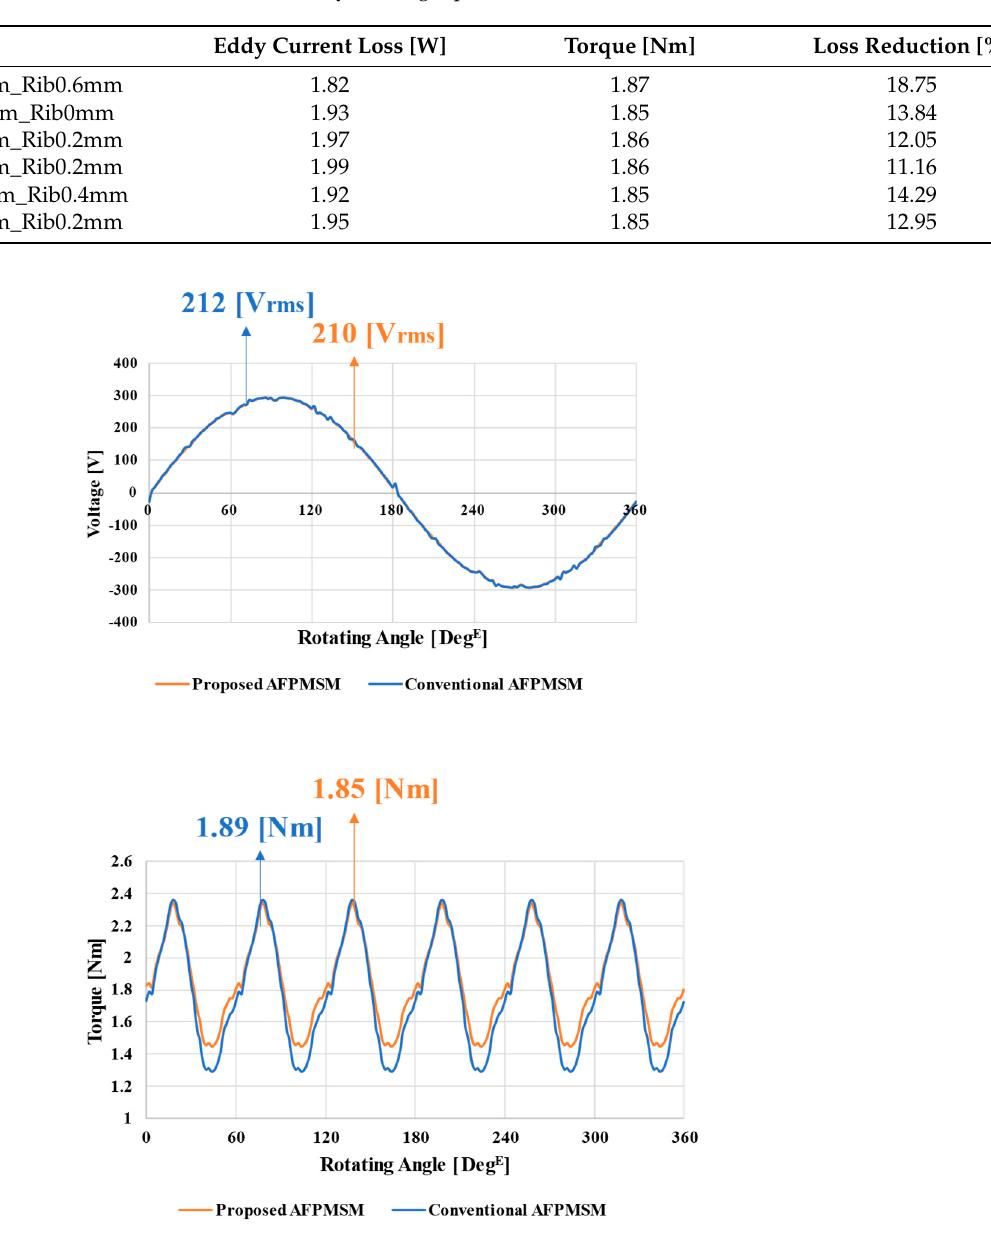
Table 3. Models that satisfy the target performance.